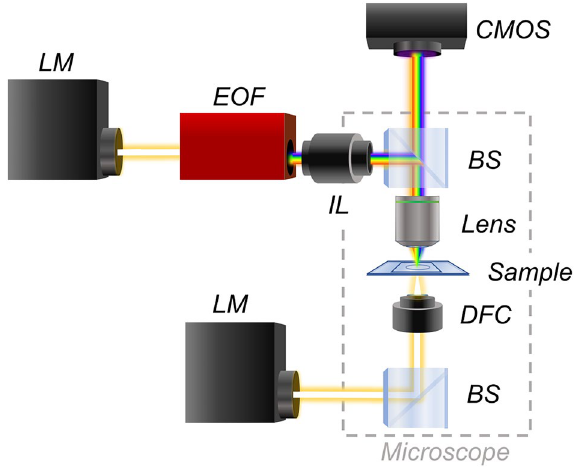
Figure 1. Schematic drawing of the customized optical instrument; the sample imaging is performed in transmission mode, while the sample spectrophotometry is done in reflection